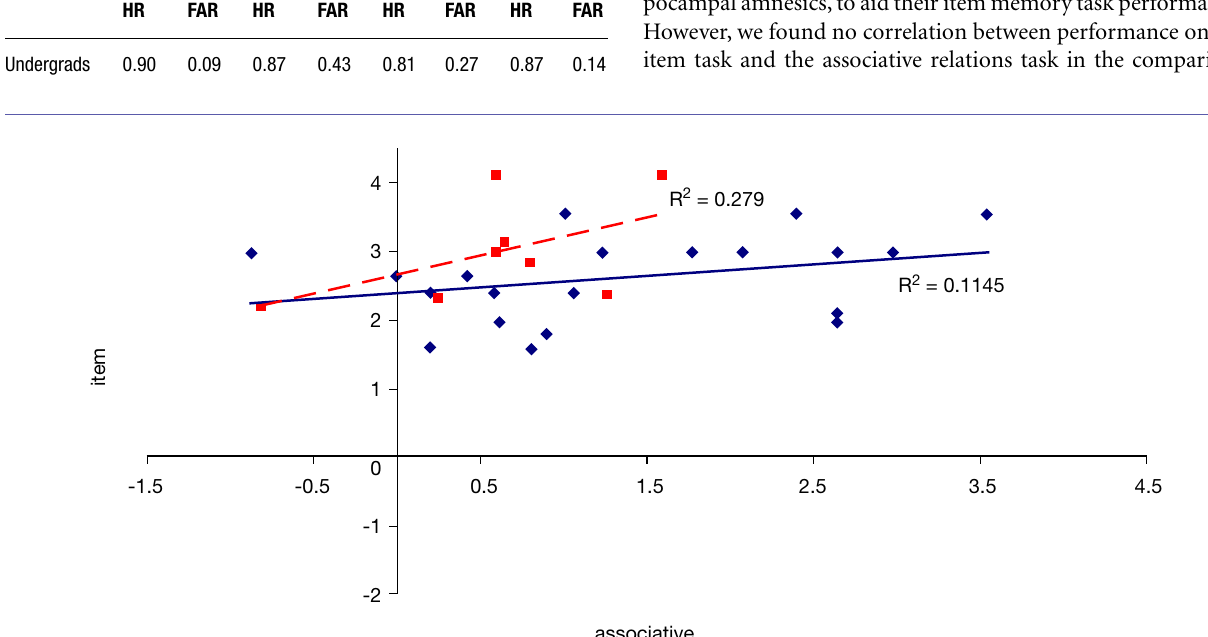
Figure 11 | Scatter plot of performance on the item and associative tasks with linear fi t and R -squared values for control (Experiment 1, in red squares and dashed line) and college-age (Experiment 3, in blue circles and solid line) participants. Neither correlation was signifi cant.